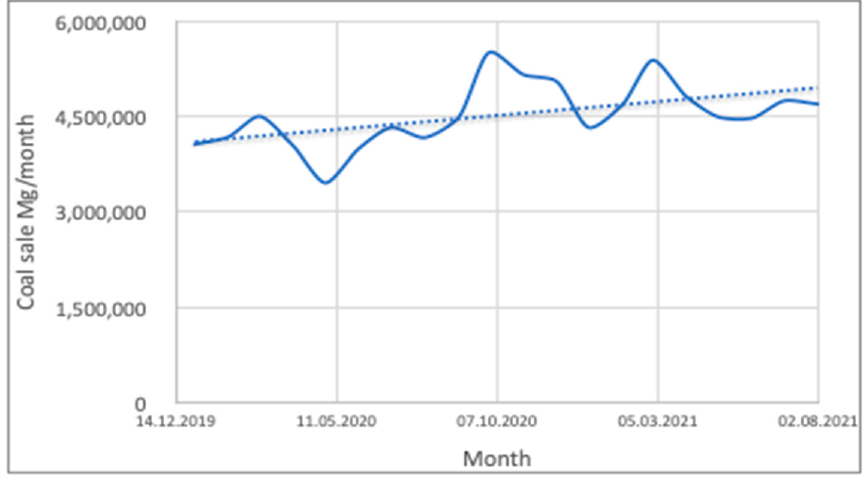
Figure 4. Hard coal demand in Poland in the period 1 January 2020–8 January 2021 and the linear trend of the time series [32].